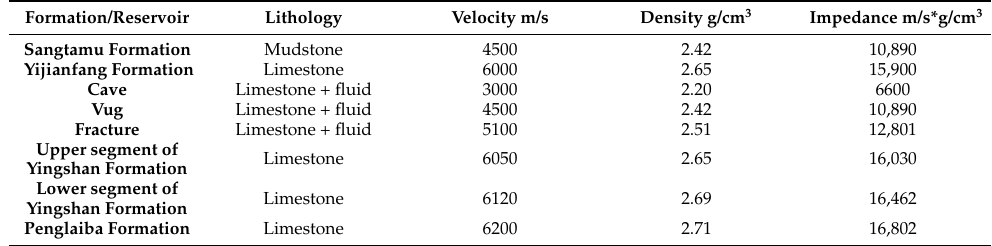
Table 1. Petrophysical parameters of Ordovician strata and the reservoir in the Shunbei area. Formation/Reservoir